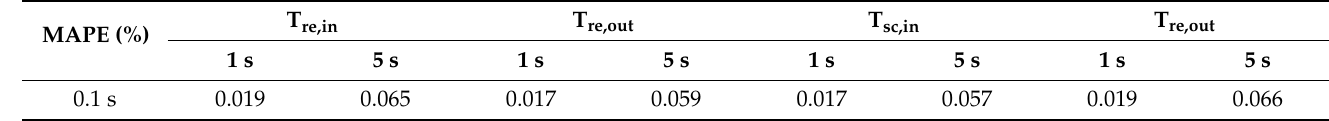
Table 5. MAPEs for time-step independence under 9.5 × 10 6 mesh density.